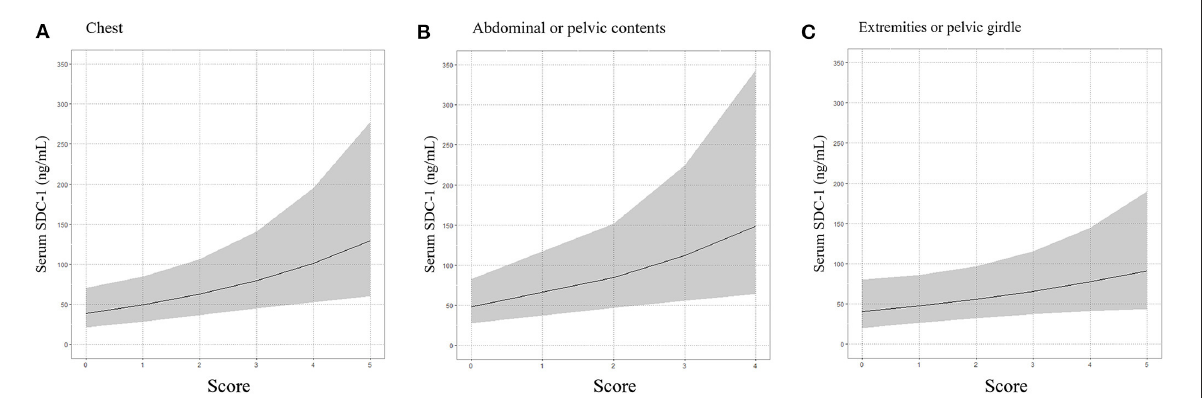
FIGURE3 Association between serum SDC-1 and chest (A) , abdominal or pelvic contents (B) and extremities or pelvic girdle (C) , body regions defined by the AIS used to calculate ISS score.